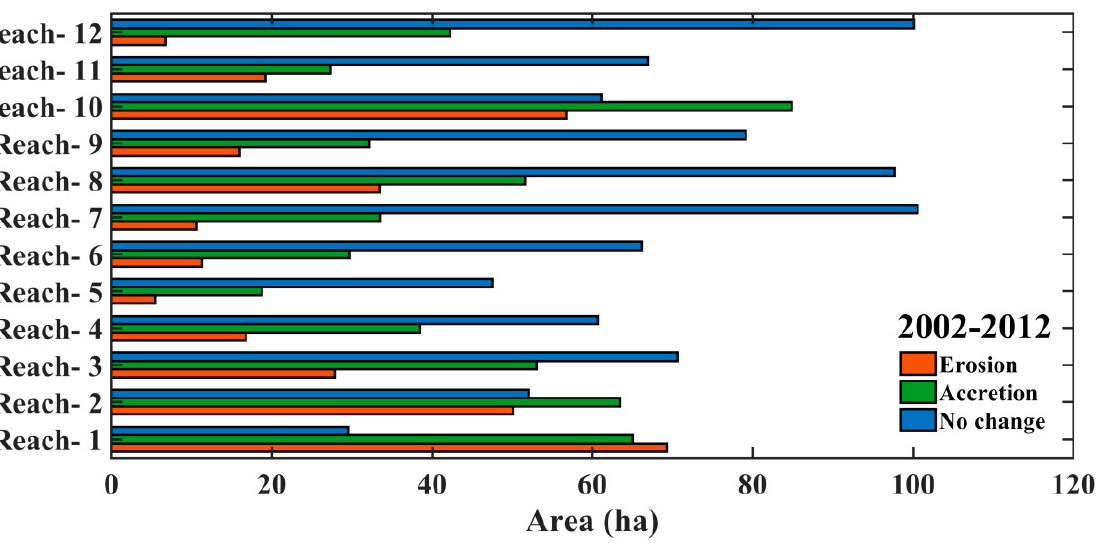
Figure 10. Erosion, accretion, and unchanged area at various reaches (1–12) between